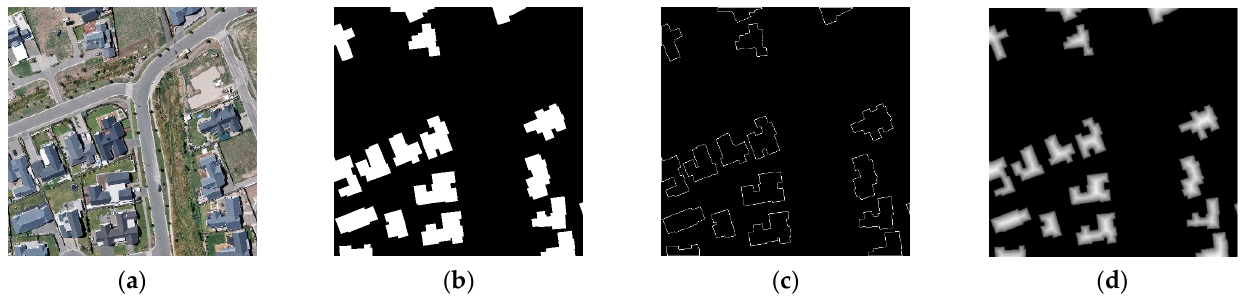
Figure 1. Example of different building-output representations. ( a ) Original RGB image; ( b ) building mask; ( c ) boundary map; ( d ) signed distance map.